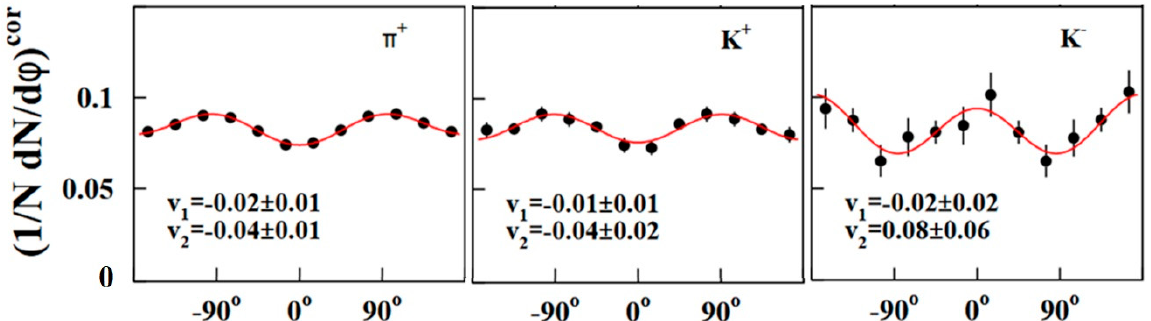
Figure 11. Azimuthal angular distributions of π + , K + and K − mesons (from left to right ) measured in semi-central Ni+Ni collisions at 1.93A·GeV [46]. The mesons are measured within a rapidity range of 0.3 < y/y beam < 0.7 and a momentum range of 0.2 GeV/c < p t < 0.8 GeV/c. The data are fitted using the first two components of a Fourier series dN/d Φ ∼ 2 v 1 cos( φ ) + 2 v 2 cos(2 φ ). The resulting values for v 1 and v 2 are indicated.